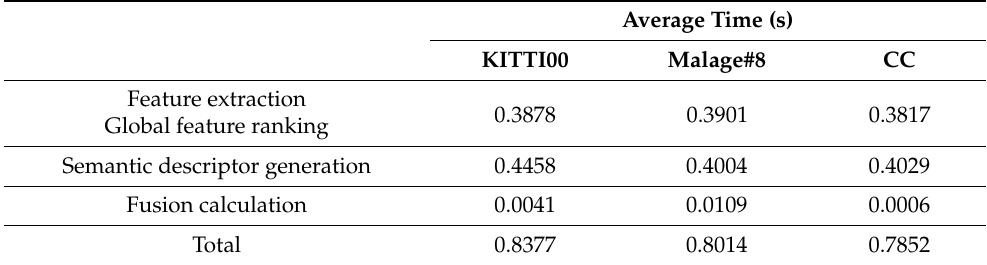
Table 4. Average processing time of per image in KITTI00, Malaga#8 and CC